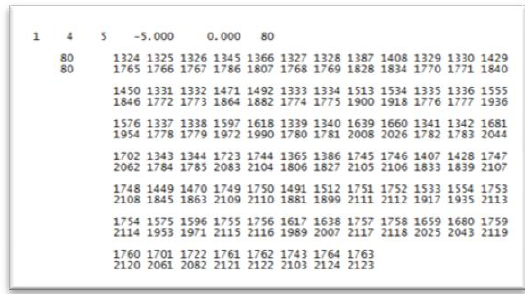
Figure 14. Relational matching for